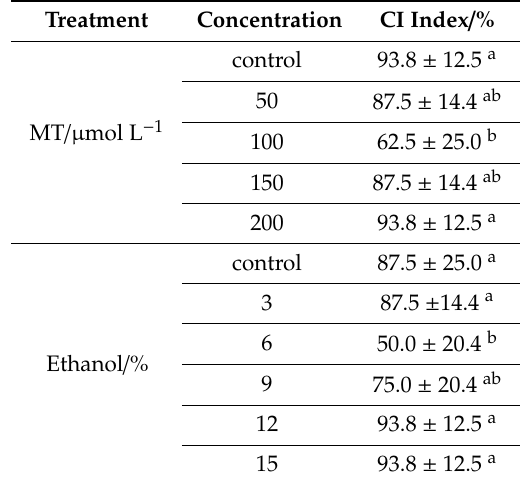
Table 3. The correlation of the response data between three factors and three dependent variables are expressed by quadratic multiple regression equations as follows (Equations